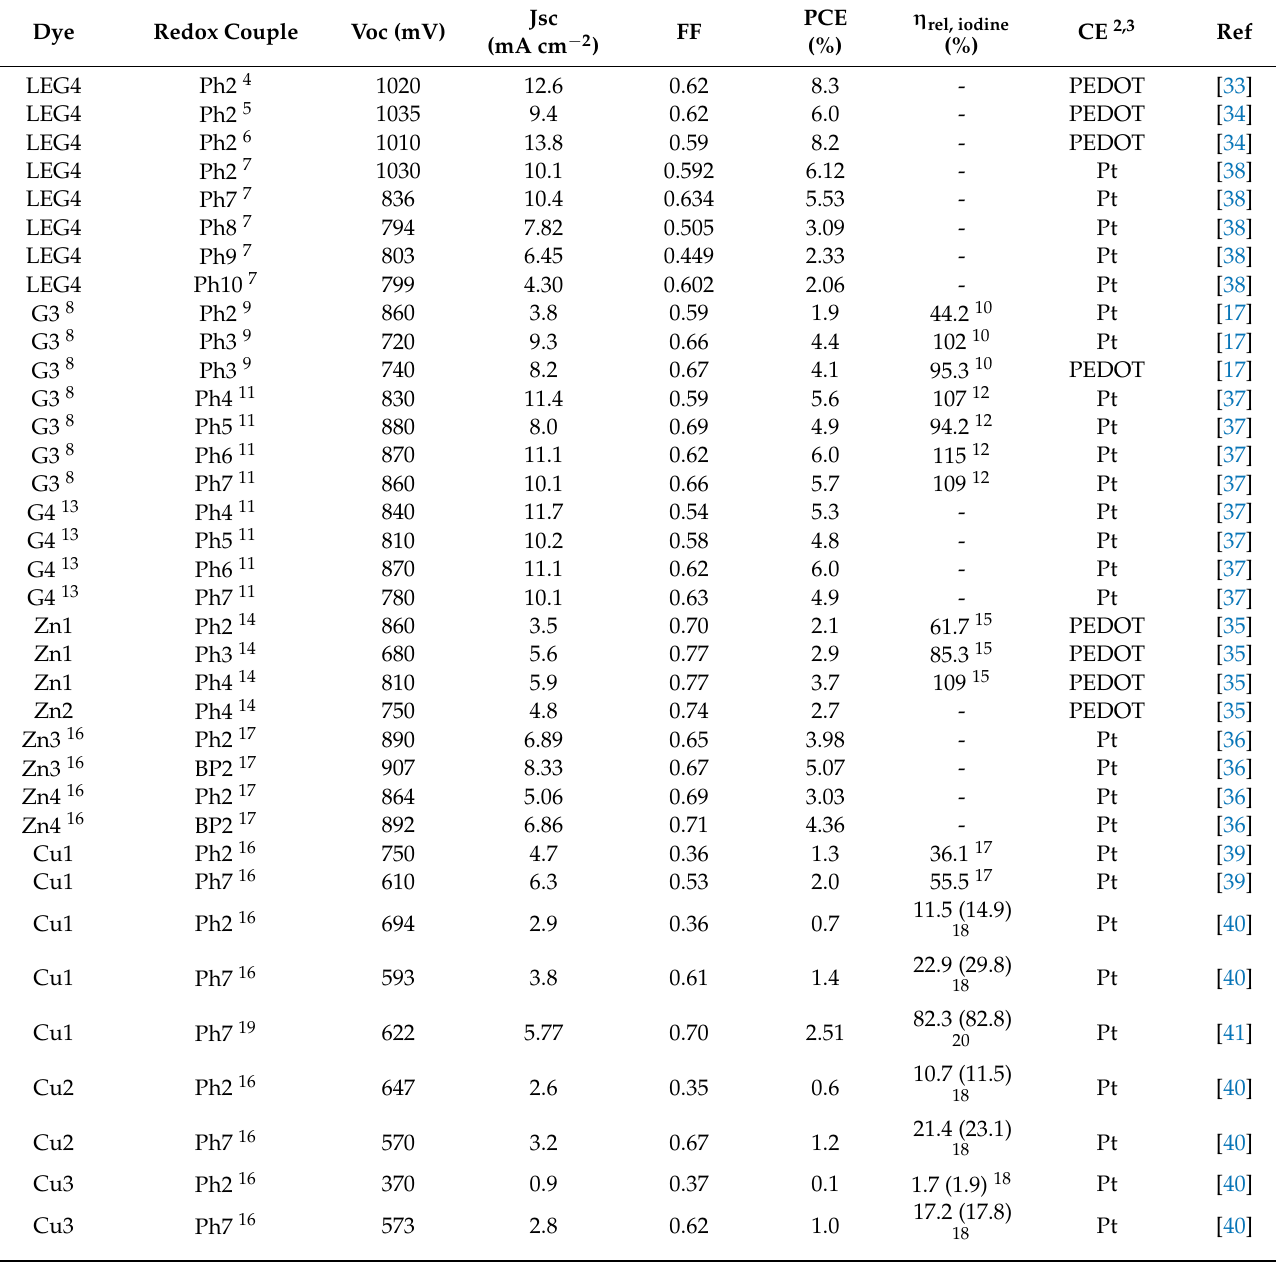
Table 1. Photoelectrochemical data of solar cells filled with phenantroline copper complexes as redox mediators. 1